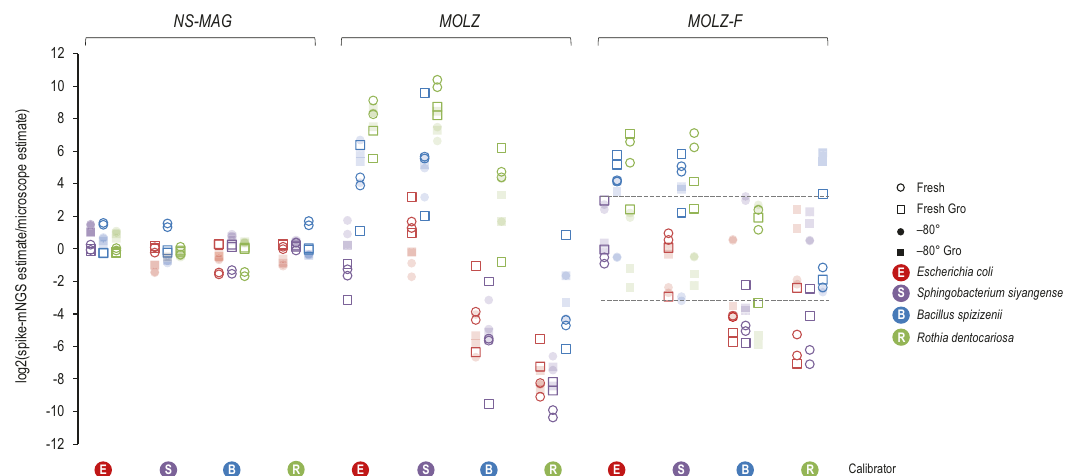
Fig. 4 log2-transformed ratio between spike-based mNGS and microscopic quanti fi cation of the mock-community members. The mock- community member used as a calibrator to calculate the absolute abundance of the three other co-spiked organisms is marked on the bottom line. Dashed lines denote the range of values obtained for samples stored at – 80 °C without glycerol and processed using the MOLZ-F method.